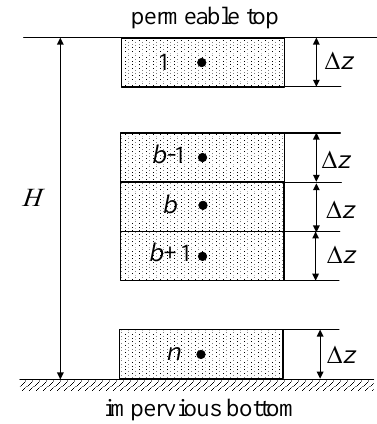
Figure 8. Discretized schematic of the soil layer.